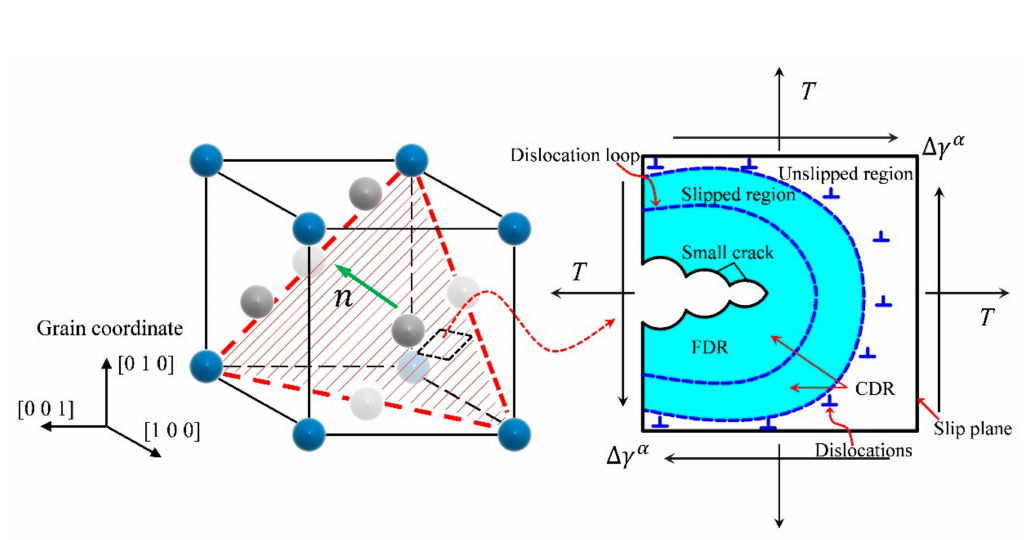
Figure 2. The local multiaxial stress state in fatigue damage region (FDR) and cyclic plastic region (CPR) on the specific slip